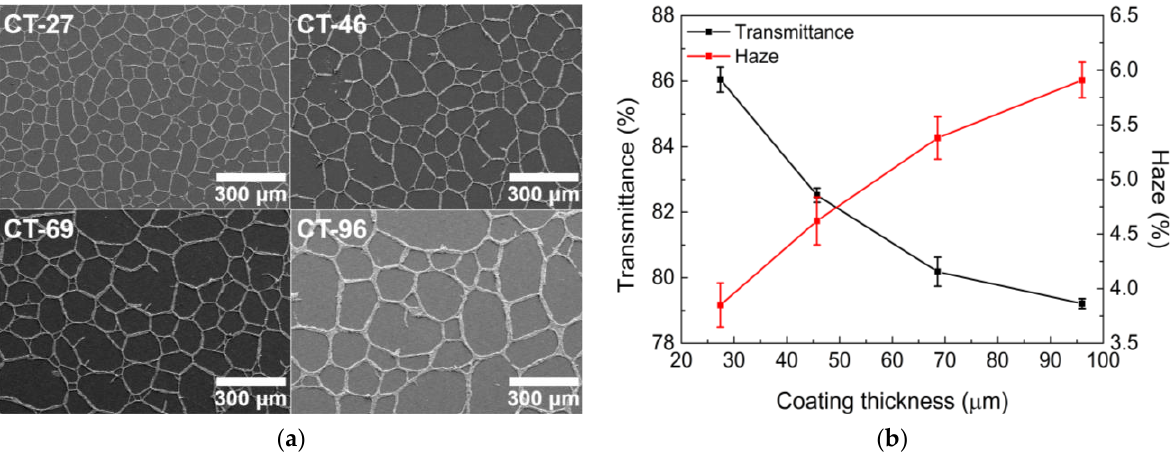
Figure 6. ( a ) SEM images and ( b ) optical properties of TCFs under different coating thickness con- ditions.